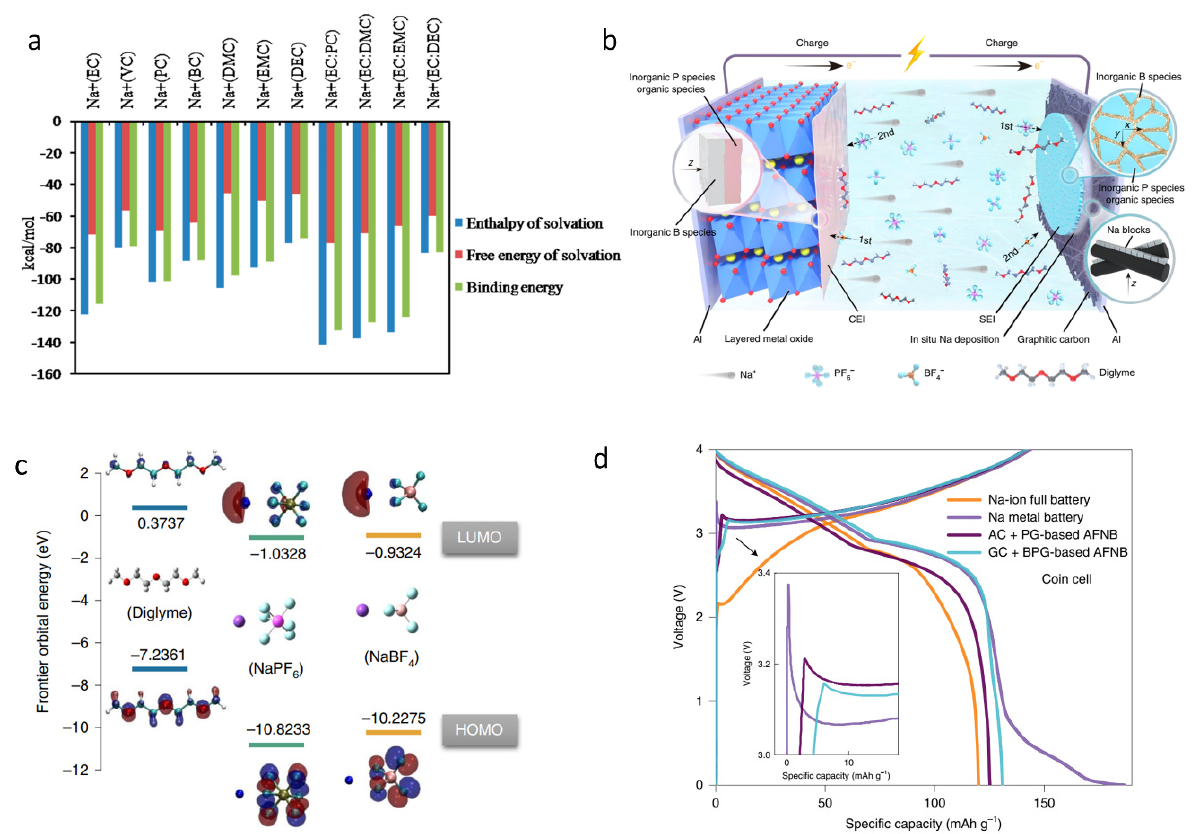
Figure 2. Strategies for the optimization of electrolytes. ( a ) Comparison of the differences in the solvation energies of Na + with commonly used pure and mixture solvents; [12] copyright 2015 American Chemical Society. ( b ) A representative AFSMB cell with the layered metal oxide serving as the cathode and the graphitic carbon–coated Al foil acting as the current collector with no Na content at the anode side. The 0.9 M NaPF 6 and 0.1 M NaBF 4 in diglyme is used as the electrolyte; ( c ) the calculated LUMO and HOMO values of the diglyme, NaPF 6, and NaBF 4 salts; ( d ) The initial discharge/charge profiles of Na-ion battery, Na metal battery, amorphous and graphitic carbon–coated current collector based anode–free cells at a current rate of 0.5 C [23]. Reproduced with the permission of ref. [23], copyright 2022 Springer Nature.